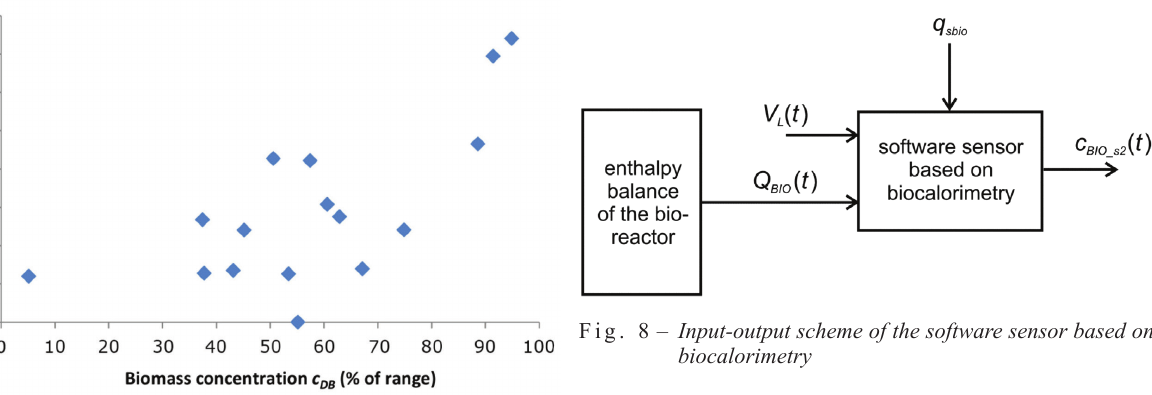
Fig. 6 – Results of calorimetric measurements in the labora- tory calorimeter taken during the cultivation C1